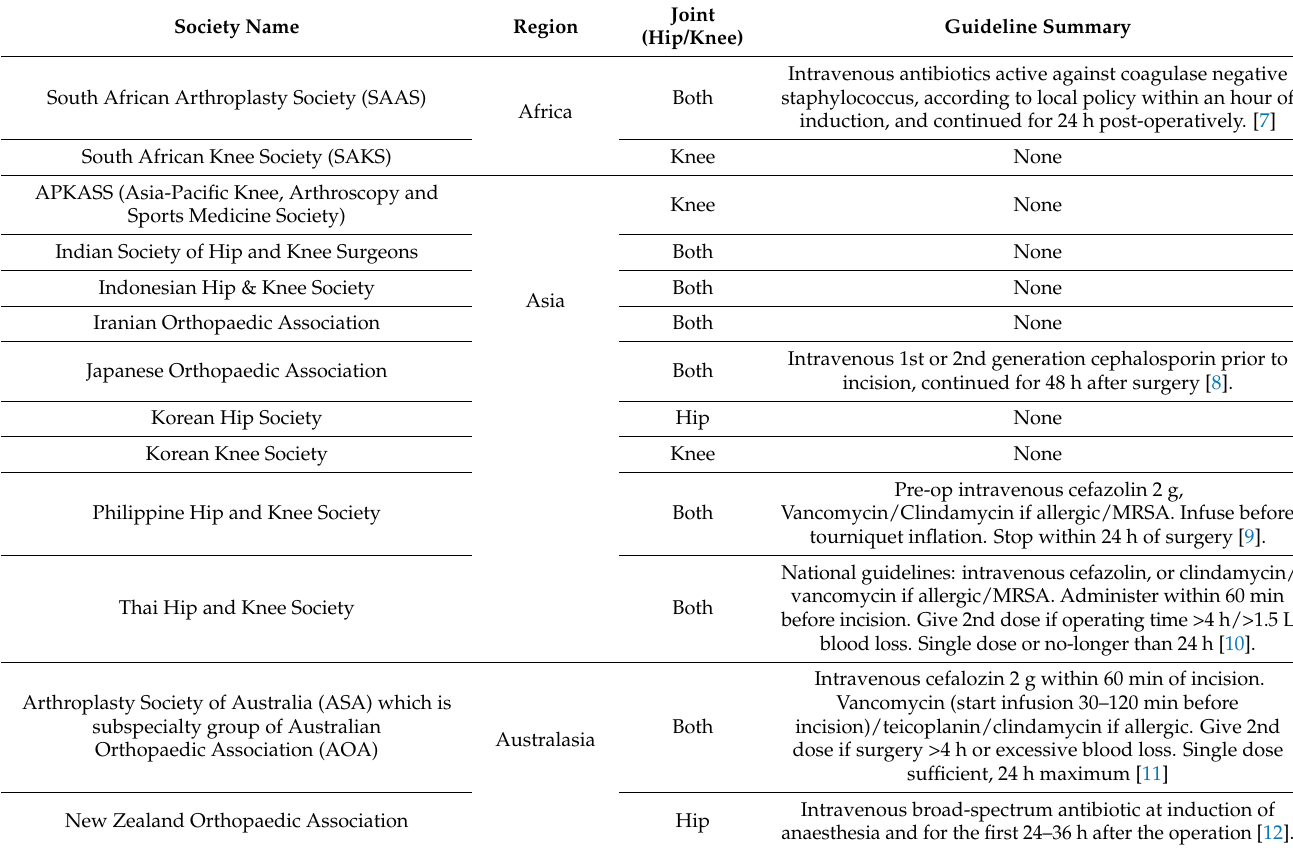
Table 1. Summary of International guidelines ordered by region in alphabetical